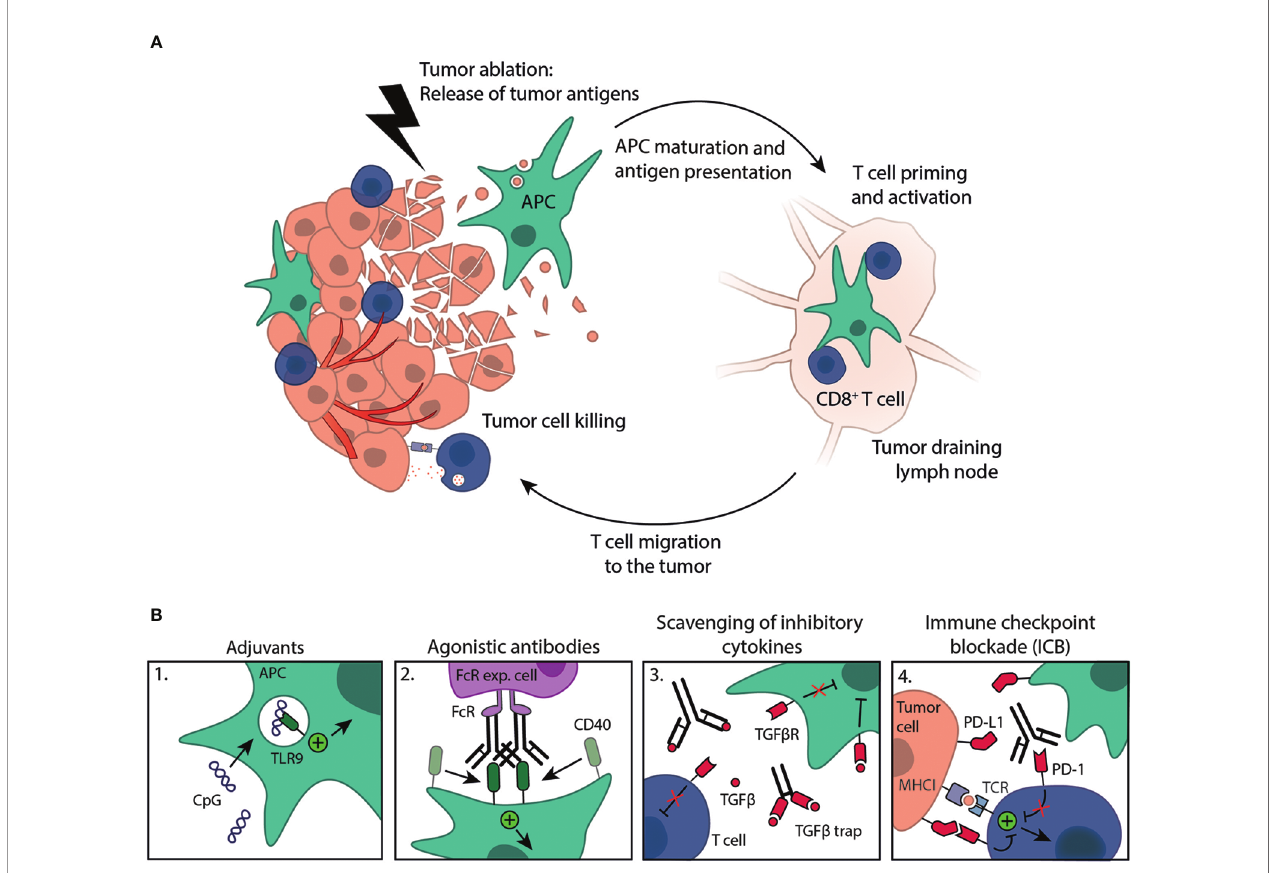
FIGURE 1 | Immune activation strategies plus tumor ablation to create in situ cancer vaccines. (A) Tumor ablation results in the release of tumor antigens available for uptake by antigen-presenting cells (APC), such as DCs. These antigens are (cross-)presented on MHC molecules to T cells in the dLN, resulting in T cell priming and activation. Activated T cells subsequently migrate to the destructed tumor, as well as distant metastases, where they kill remaining tumor cells. (B) Immune response induction is boosted by exogenous administration of immune stimulating compounds like 1. adjuvants (e.g. CpG) or 2. agonistic antibodies (e.g. anti-CD40 mAb, crosslinking by Fc-receptor expressing cells) that can work synergistically with tumor ablation in creating effective, mature DCs. Furthermore, several approaches can be exploited to counteract the immunosuppressive TME, such as 3. scavenging of inhibitory cytokines (e.g. anti-TGF b mAb or TGF b trap) or 4. immune checkpoint blockade (ICB, e.g. anti-PD-1 mAb), both to enhance the anti-tumor immune